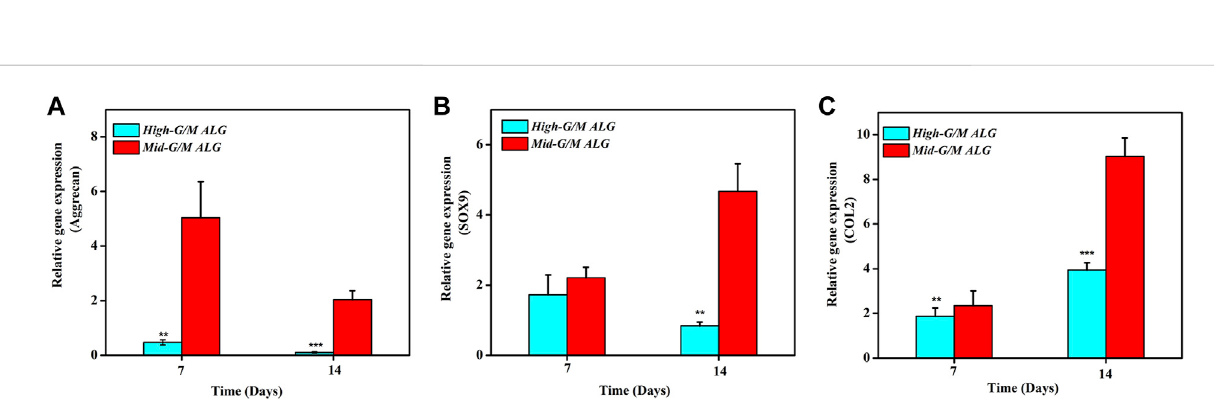
FIGURE 5 EffectsofHigh-G/MALG/COLandMid-G/MALG/COLhydrogelsonmRNAexpression,asquanti fi edby2 − ΔΔ Ct at7and14 days. (A – C) :qPCRanalysis ofAggrecan,SOX9 and COL2 mRNA expression. Dates are represented as themean± SD (n =3).(** p < 0.01,*** p < 0.001 indicate signi fi cant differences among the